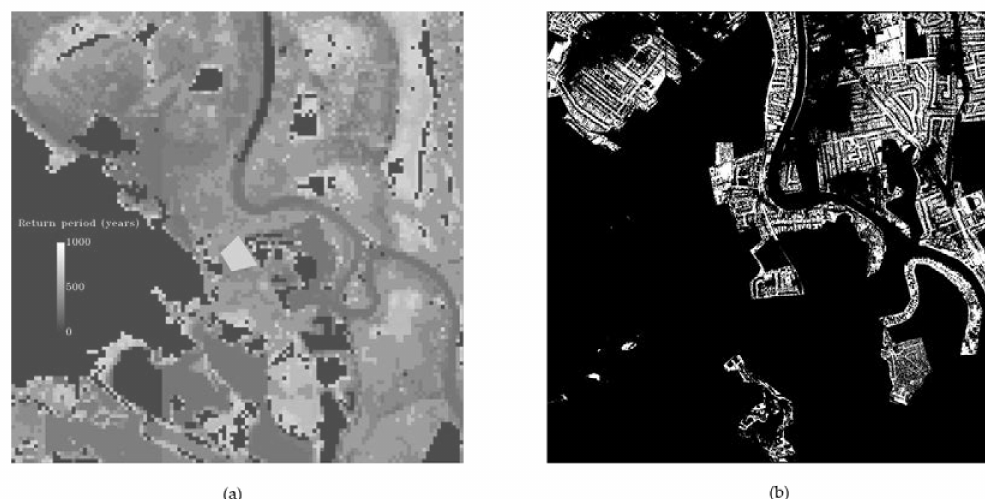
Figure 10. ( a ) Return-period map for Staines with protective ‘wall’ around the validation area including Blackett Close (c/f Figure 6c, black areas masked out), and ( b ) urban flood classification using the SAR image of 13 February 2014, showing the unflooded validation area (white —